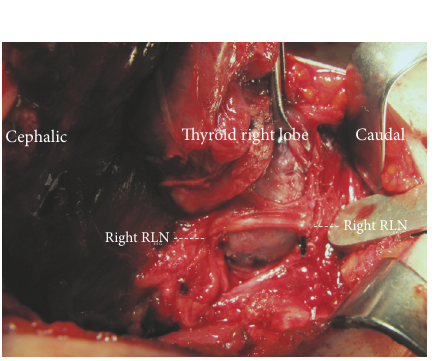
Figure1:Displacementoftherightrecurrentlaryngealnerve(RLN) adherent to the lateral surface of recurrent goiter mass.